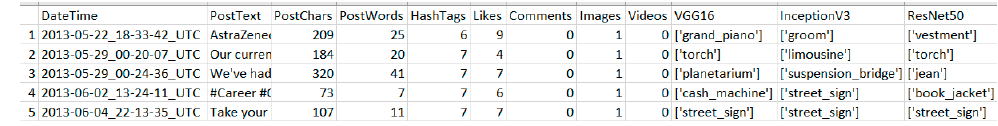
Figure 2. astrazeneca account posts metadata.